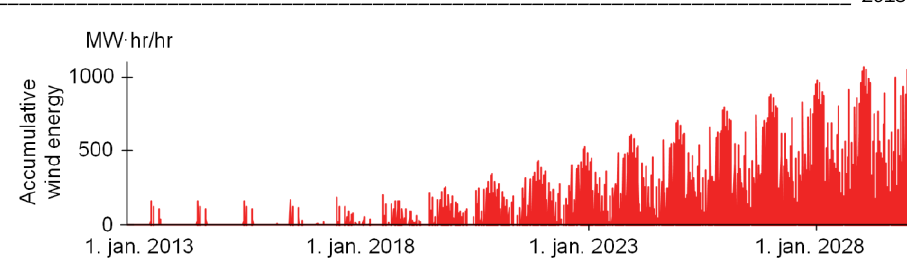
Fig. 5. Accumulated wind energy in first scenario.